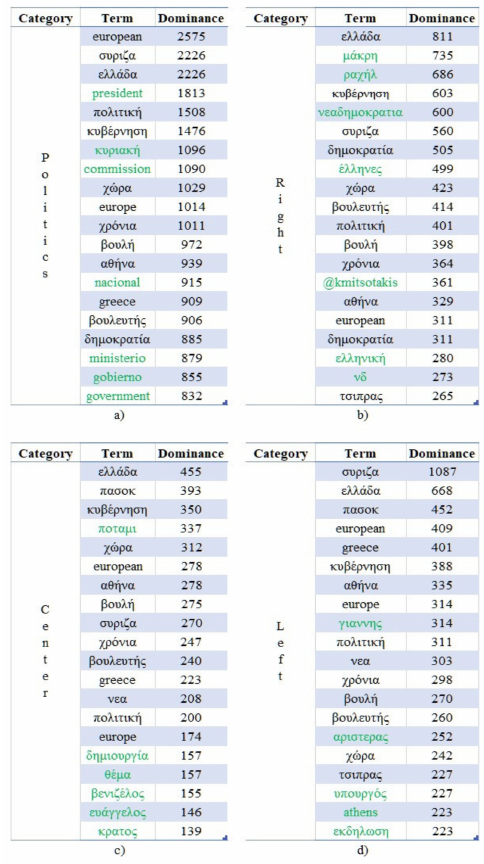
Figure 6. The top 20 dominant OCR terms ( a – d ) per community of